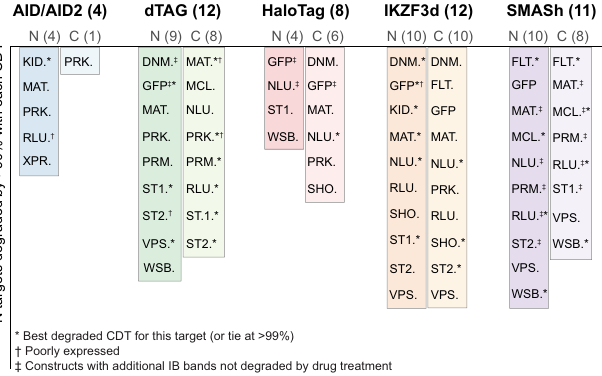
Fig. 2 | Comparison of degradation ef fi ciency for fi ve CDTs across 16 unique proteinsofinterest.a ExpressionanddegradationacrossCDTfusionsto16unique proteins of interest (POI). The indicated POI-CDT fusions were expressed in HEK- 293T cells treated with DMSO or the respective degrader drug and analyzed by immunoblot (IB, see Supplementary Figs. 2 – 6). The size of each dot corresponds to the baseline expression level of that fusion protein: the anti-V5 IB band intensity normalizedtotheanti-Vinculinbandintensityandthenscaledtothetotalexpression of all 10 CDTs evaluated for a given target to highlight the relative expression dif- ferences betweenthedifferent CDTs.The colorof eachpointindicates the maximal degradation observed (D max ) for that protein after degrader drug treatment. Note that missing data points indicate that the fusion protein was not evaluated and that some of the SMASh-tag constructs were ef fi ciently degraded at later timepoints, as